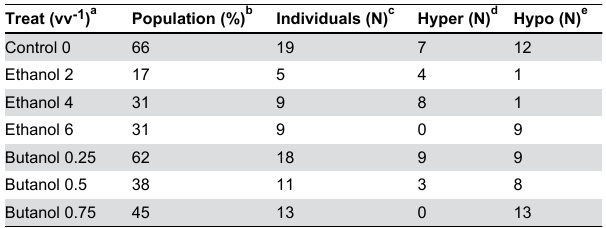
Table 1. Summary of tertiary screening of Fusarium oxysporum strain 11C transformants to investigate the level of altered alcohol tolerance across a selected sub- population of individuals ( n